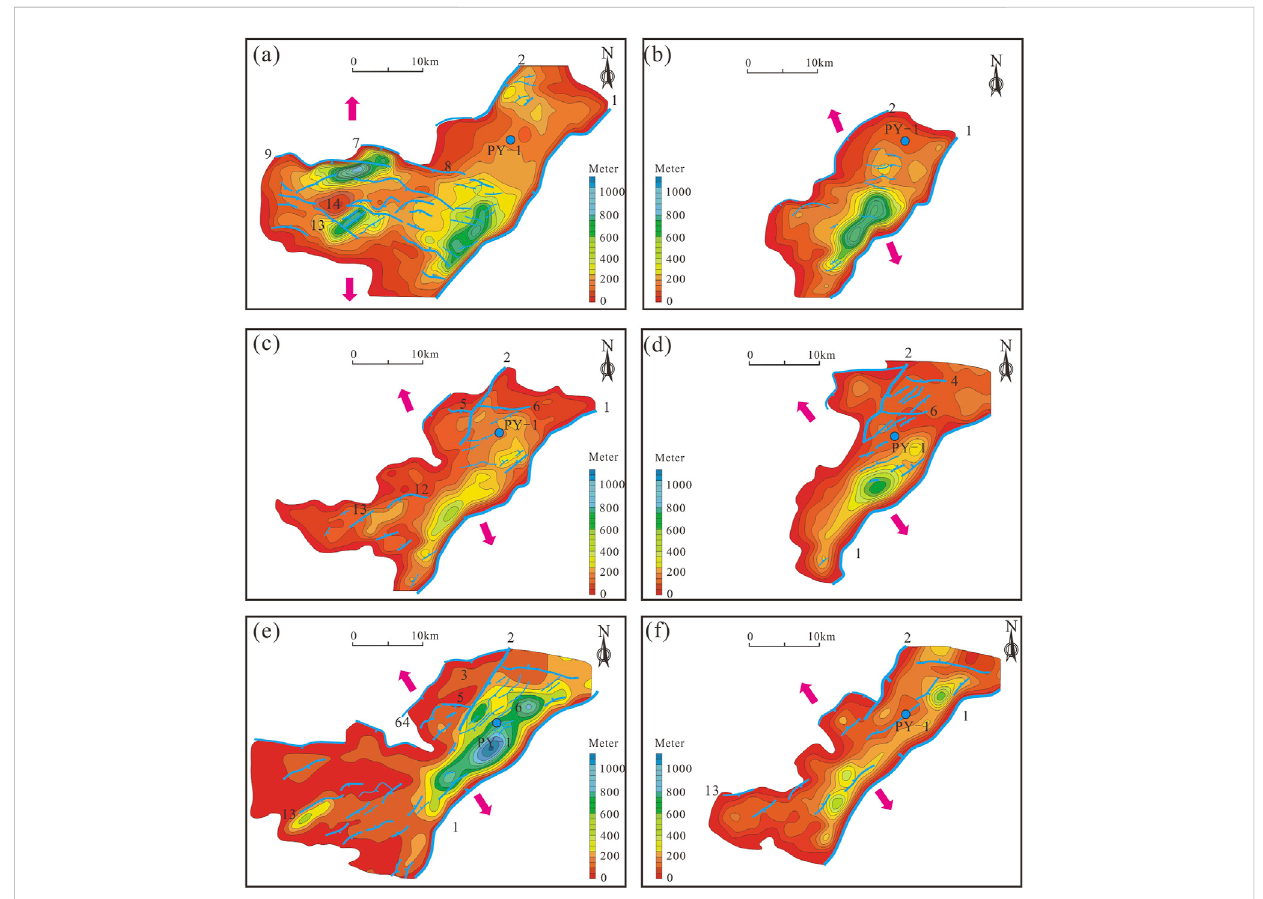
FIGURE 10 The superimposition of original sediment thickness and syn-sedimentary faults from Member 1 to Member 6 [from (A – F) ] in Panyu 4